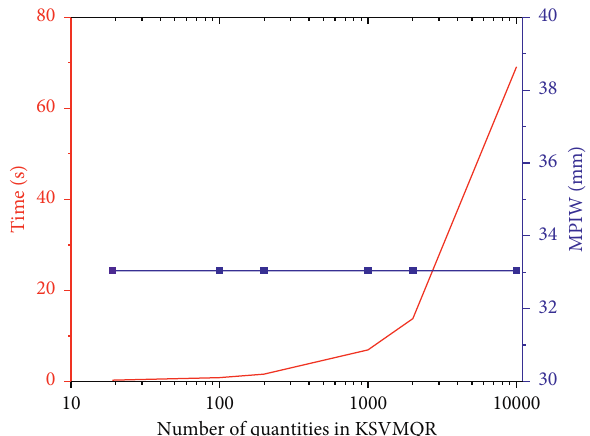
Figure 11: Comparisons of the median predictions ( 􏽢 y τ � 0 . 5 observations for ZG 287 and ZG289.